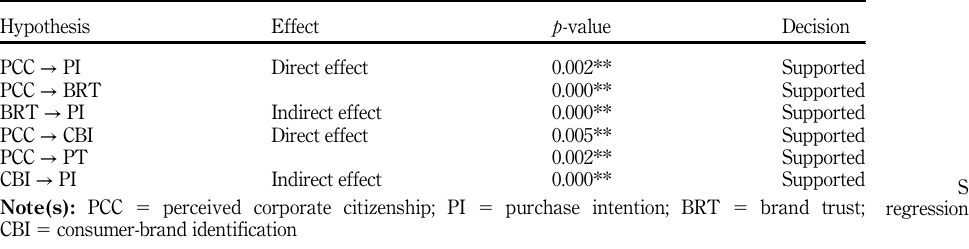
Table 3. Standardised regression weight and p